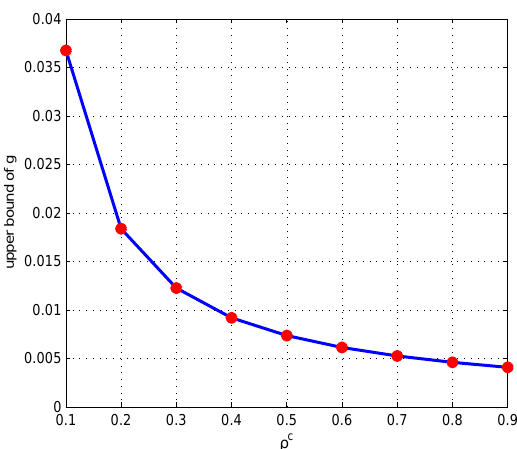
Figure 5. Upper bound of g for a fixed ρ c = 0.7.